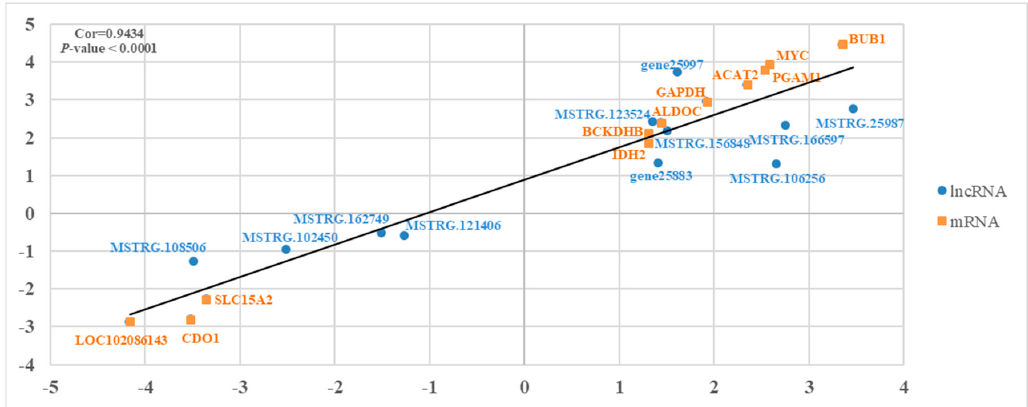
Figure 6. An illustration of the qPCR confirmation for the RNA-seq. The correlations of the gene expression level of the 11 di ff erentially expressed genes and the 11 lncRNAs between lactating and non-‘lactating’ crops using RNA-Seq and a qRT-PCR. The X-axis and Y-axis show the log 2 Foldchange (T / C) measured by the RNA-seq and qRT-PCR, respectively. T represents ‘lactating’ pigeons and C represents non-‘lactating’ pigeons. The β -actin gene was used as a housekeeping internal